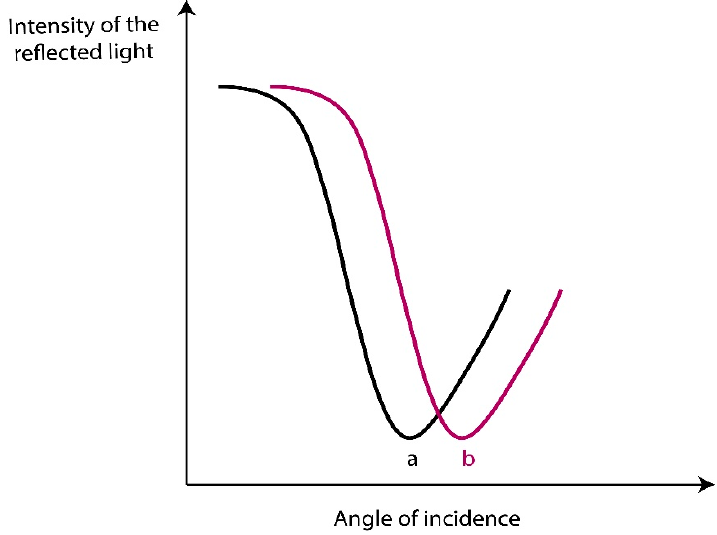
Figure 2. ( a ) A dip in the intensity of the reflected light after SPs excitation and ( b ) an angular shift from a to b due to a refractive index (RI) change on the Au film.